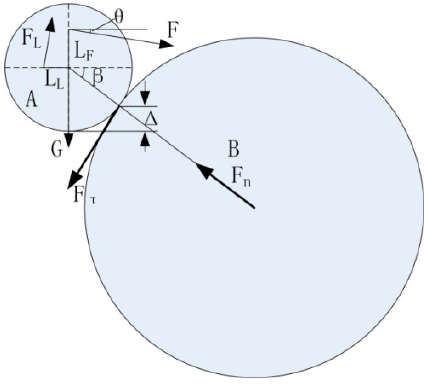
Figure 2. Forces on the movable particles.